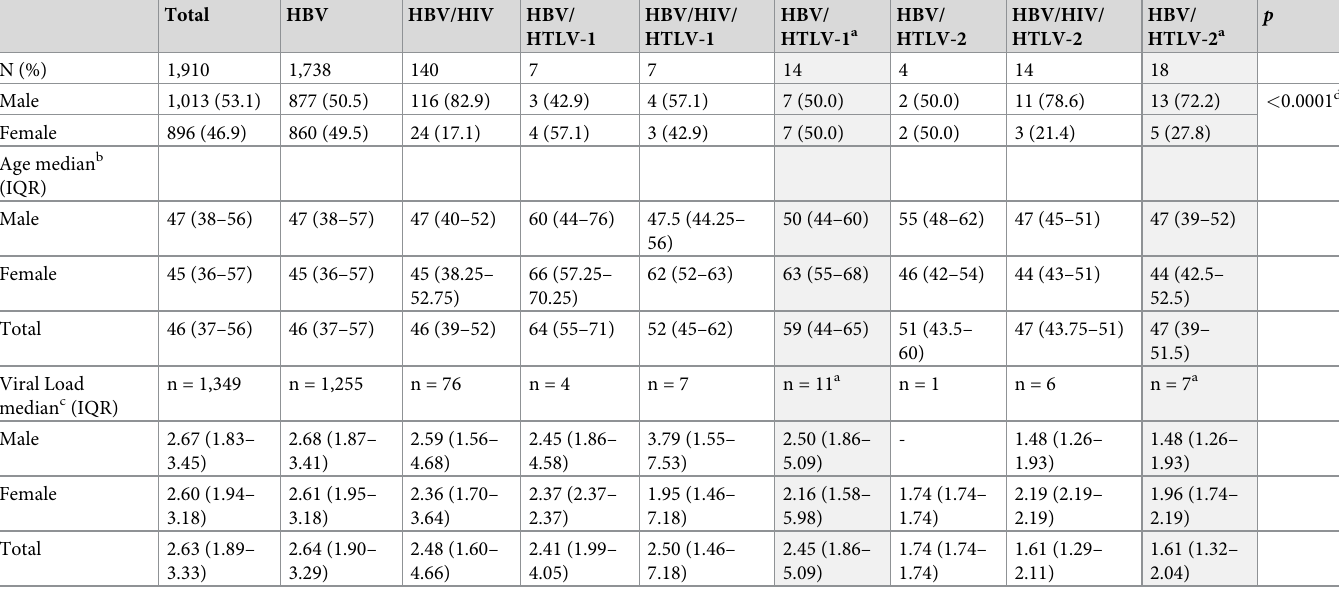
N, number; %, percentage a , HBV/HTLV coinfected groups regardless of HIV status used for statistical analysis b , age in years; IQR, interquartile range between 25% and 75% c , viral load in log 10 . HBV viral load determination using the Abbott Real-Time HBV assay (Abbott Molecular Inc., IL, USA) d , chi-square